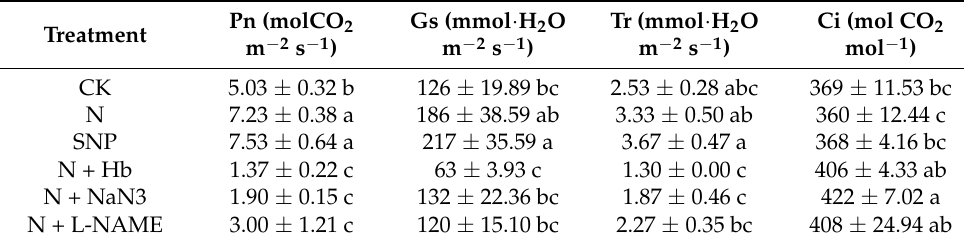
Table 3. Effects of exogenous nitric oxide, different ammonium/nitrate ratios, and the application of NO scavenger and biosynthesis inhibitors in ammonium/nitrate solution on root photosynthetic parameters in Brassica pekinesis exposed to low-light